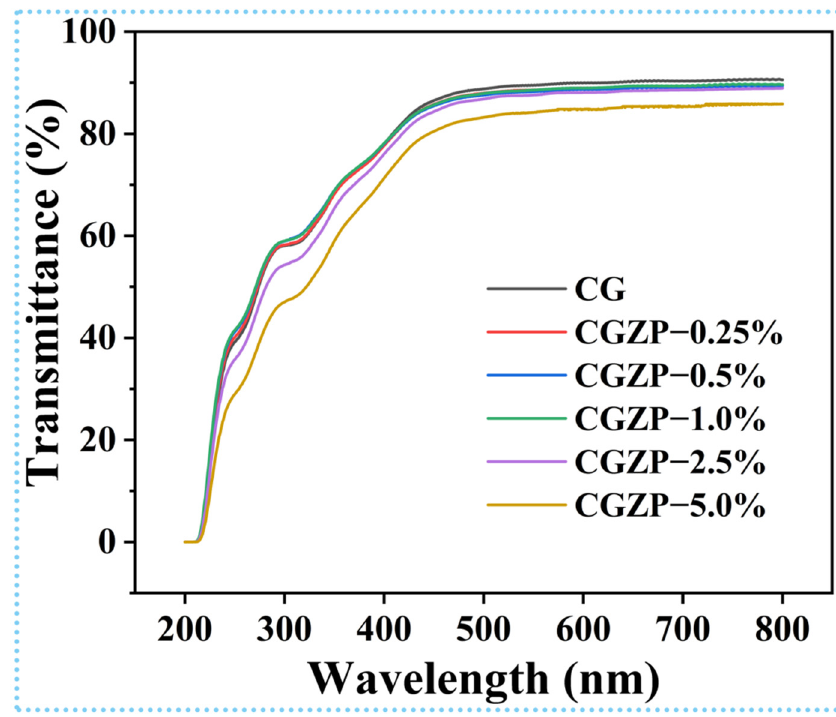
Figure 5. The light transmittance spectra of the films. Table 2. Transmittance (%) at different wavelengths (200–800 nm), thickness and opacity for CG and CGZP films. Samples